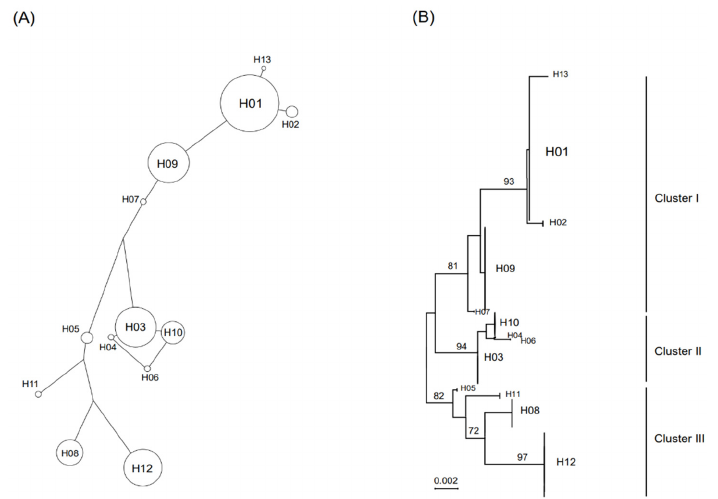
Figure 4. Haplotype network and phylogenetic tree of mtDNA sequences from wild boars captured in South Korea. Parsimonious median-joining networks depicting the relationships among wild Korean boars ( A ). A network illustrating the relationships between wild Korean boar haplotypes. The phylogenetic tree was reconstructed using partial mtDNA D-loop gene sequences from 428 wild Korean boars ( B ). Thirteen haplotypes were identified using the maximum likelihood (ML) method, with 1000 replications used for bootstrap analysis (MEGA 7.0 software). All haplotypes grouped into three clusters (I, II, and III).